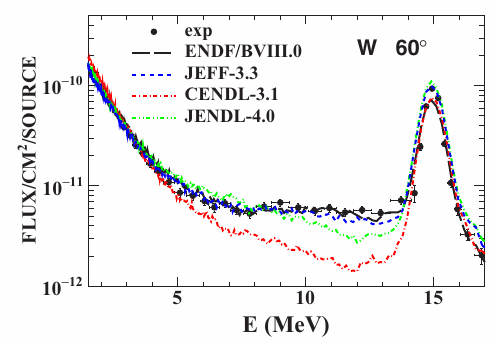
Figure 5. Neutron leakage spectra for C sample at 120 ◦ .